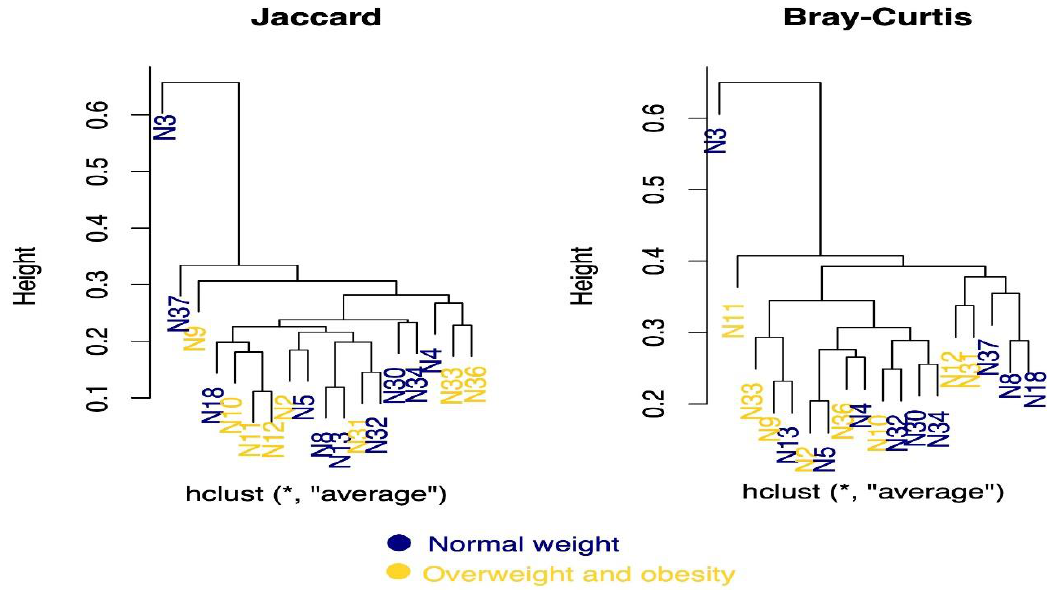
Figure 5. Beta-diversity dendrograms. These show the average distance and clustering of the individual samples according to the Jaccard and Bray-Curtis distance methods. The samples in color blue correspond to normal weight, in yellow color correspond overweight and obese adolescents.